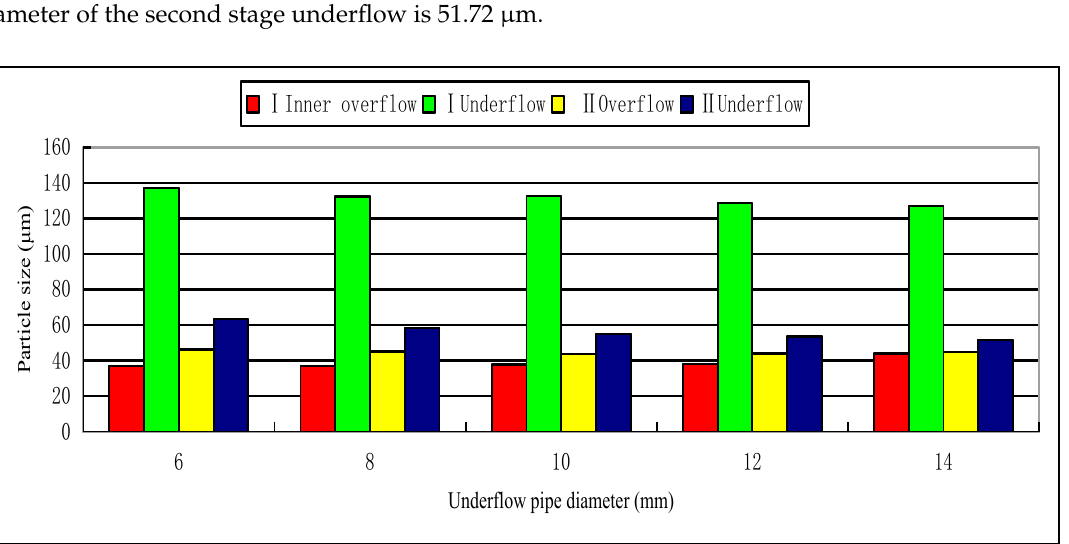
Figure 9. Comparison of maximum grain size products of different underflow pipe.